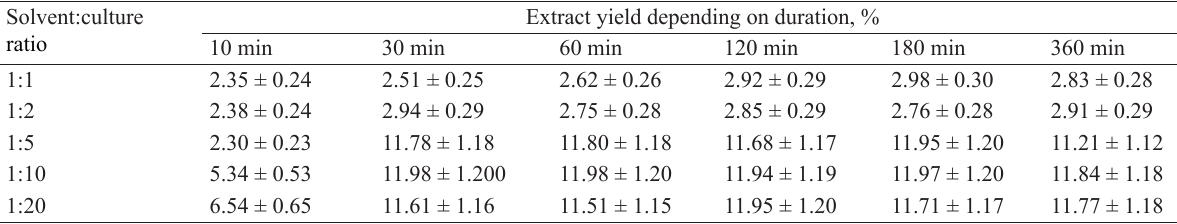
Table 5 Dry extract yield of biologically active substances from dried ginseng root culture biomass depending on extraction time (at 45°C) Solvent:culture